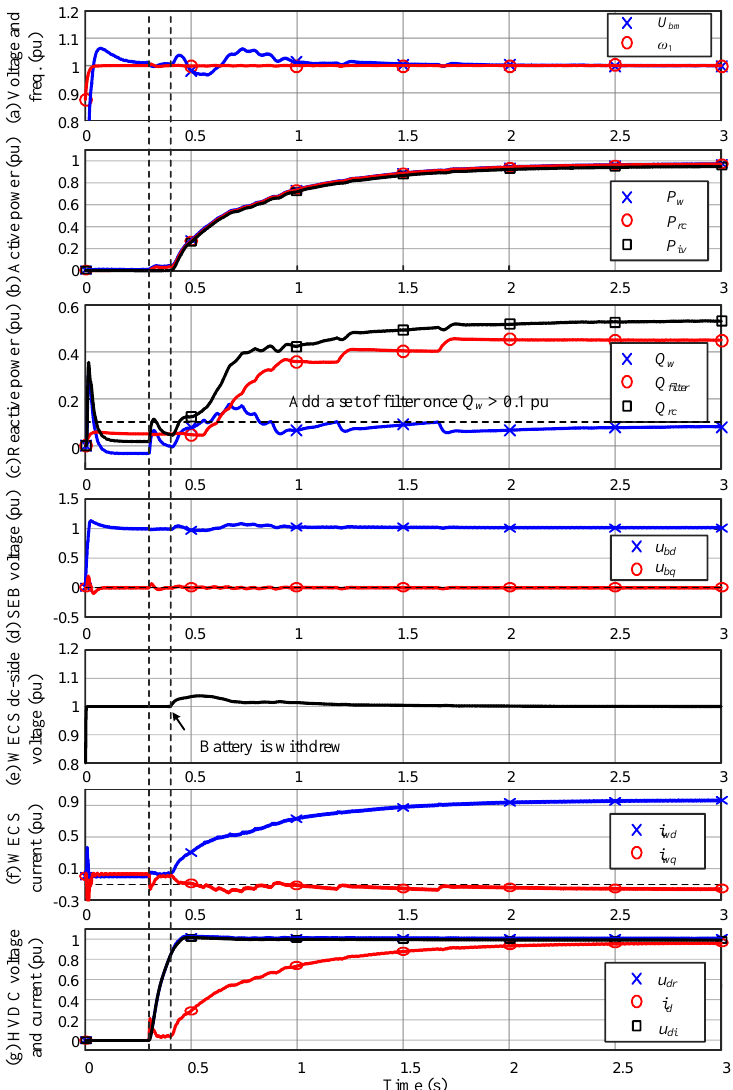
Figure 15. Simulation result of the system startup. ( a ) Sending-end bus voltage and frequency; ( b ) active power; ( c ) reactive power; ( d ) dq -axis sending-end bus voltage; ( e ) WECS DC-link voltage; ( f ) WECS output current; ( g ) HVDC DC-link voltage and current.